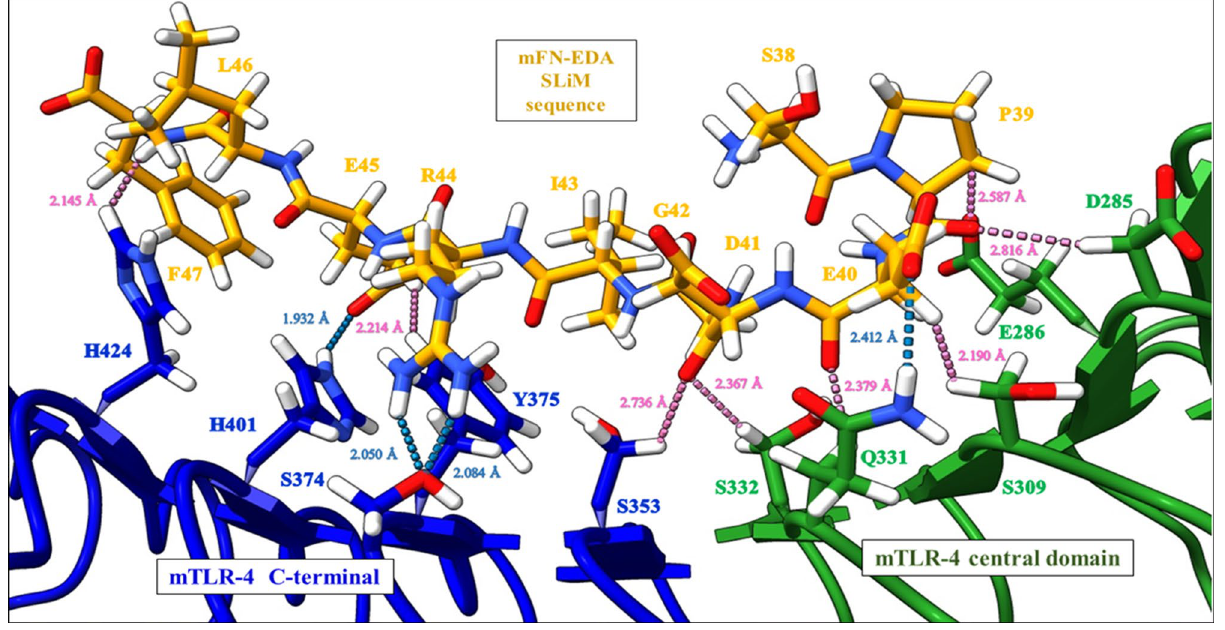
Figure 2. Protein–protein interactions of mouse FN-EDA SLiM sequence (orange sticks) with mTLR4 central domain (green sticks) and C-terminal (blue sticks) identified using ChimeraX 47,48 , showing hydrogen bonding (blue dashes) and Van-der-Waal interactions (pink dashes). mFN-EDA interacts with the residues of the central and C-terminal domains of